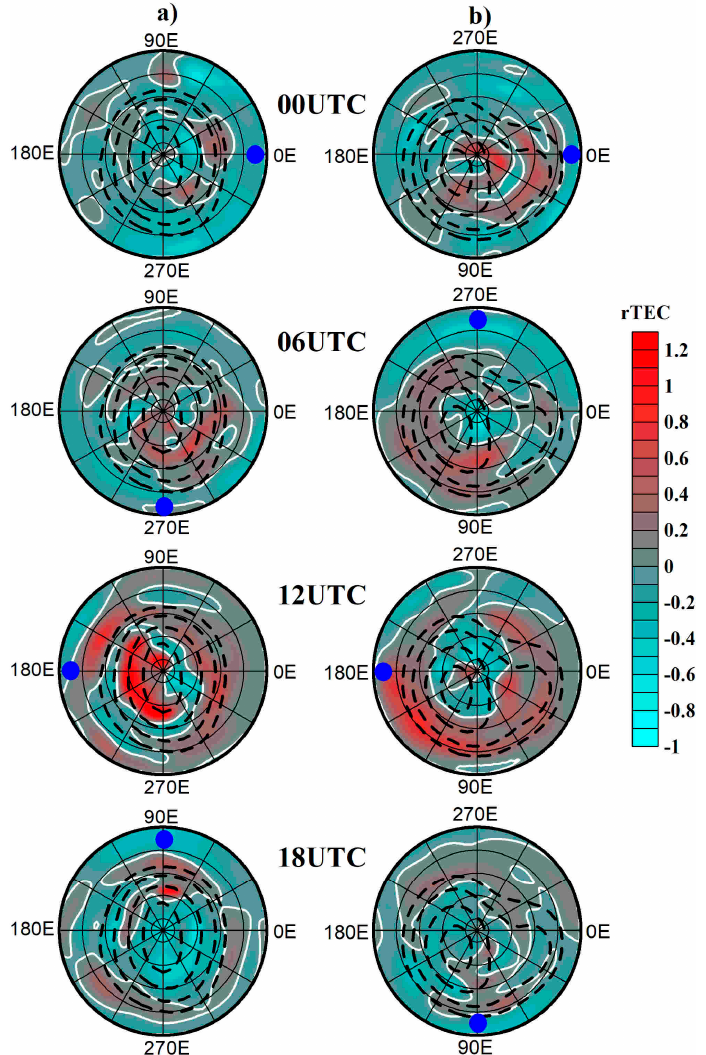
Figure 7. Latitudinal distribution of relative TEC in polar coordinates for 2 March 2022 for the northern hemisphere ( a ) and the southern hemisphere ( b ). Lines of equal inclination of the Earth’s magnetic field from 50 ◦ to 80 ◦ in 10 ◦ are indicated by dotted lines. The blue dots indicate the midnight meridian.